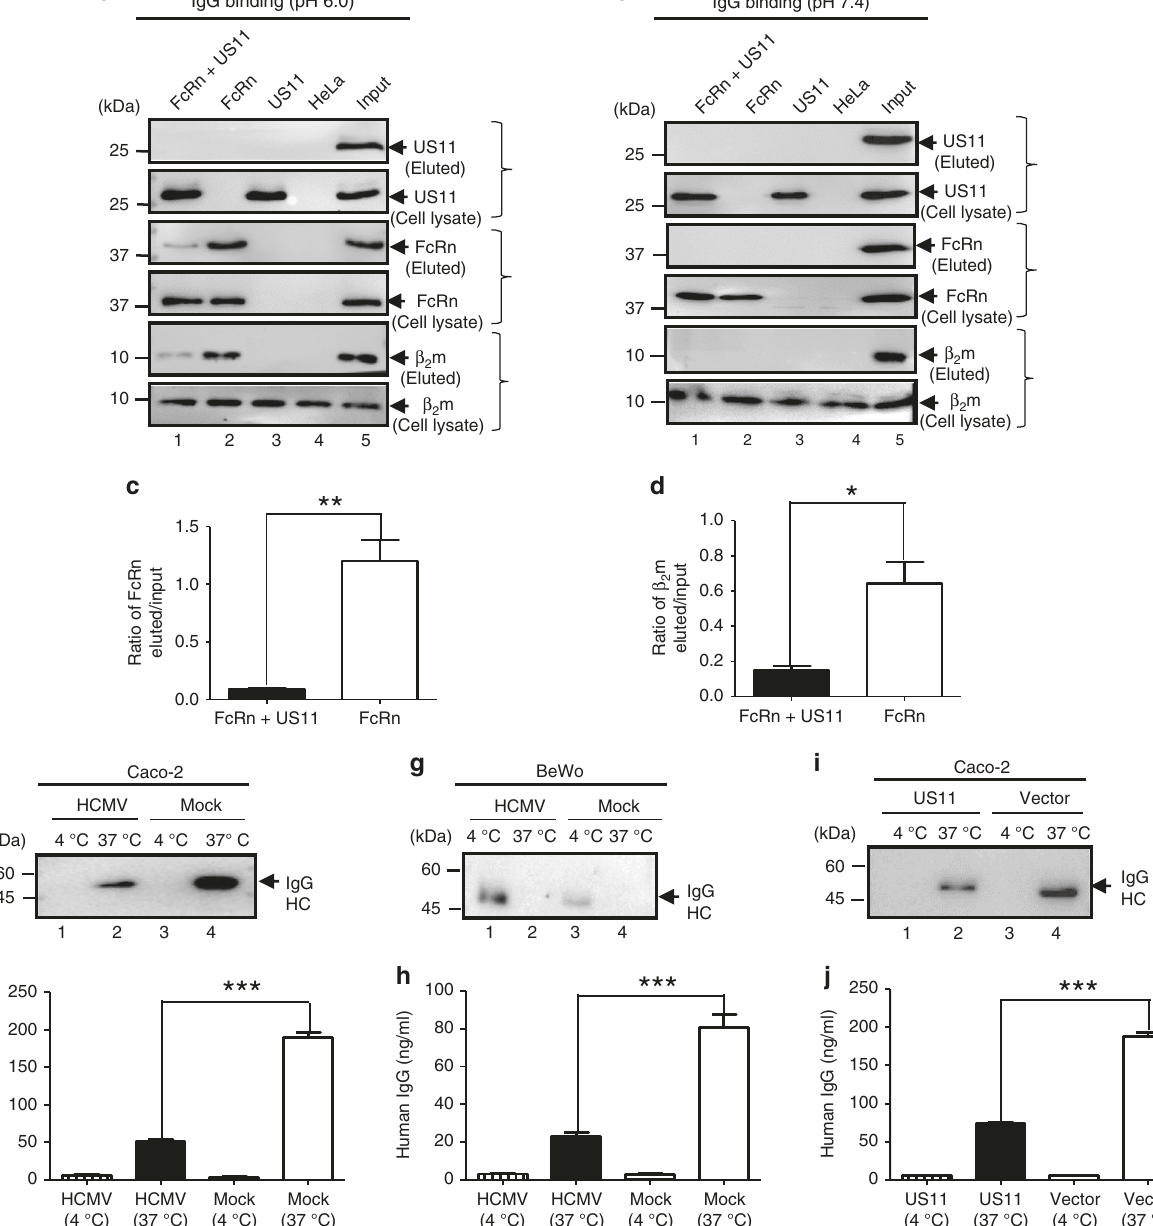
Fig. 8 HCMV and US11 reduce FcRn-mediated IgG transcytosis in epithelial monolayers. a – d The presence of US11 reduces FcRn binding to IgG. HeLa transfectants were lysed in pH 6.0 ( a ) or pH 7.4 ( b ) condition. Approximately 0.5 mg of soluble proteins were incubated with human IgG-Sepharose at 4 °C. Eluted proteins were subjected to western blotting analysis with corresponding Abs as indicated. Cell lysates were blotted as control. The amount of eluted FcRn ( c ) or β 2 m protein from HeLa FcRn and HeLa FcRn + US11 cells was compared by the ratio of the band density of eluted protein to that of input protein. The density of protein bands was quanti fi ed by the Image Lab 5.2 software. e – h Caco-2 cells (2 × 10 4 /well) or BeWo cells (10 5 /well) were grown in 0.4 μ m transwell for 8 to 10 days (Caco-2) or for 4 days (BeWo) to allow differentiation. When the transepithelial resistance r reached above 600 (Caco-2) or 400 (BeWo) ohms/cm 2 , cells were infected at the basolateral surface with HCMV (MOI 5) for 1 h. After washing, cells were incubated for 48 h. Infected or mock-infected cells were loaded at the apical surface with IgG (lanes 1 – 4) (0.5 mg/ml for Caco-2 or 0.25 mg/ml for BeWo) at 37 °C